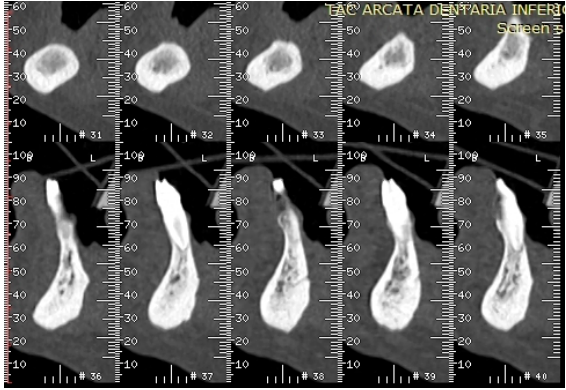
Figure 11. October 2016 follow-up visit: the oral mucosa showed no dehiscence in the areas of extractions and no other symptoms occurred.